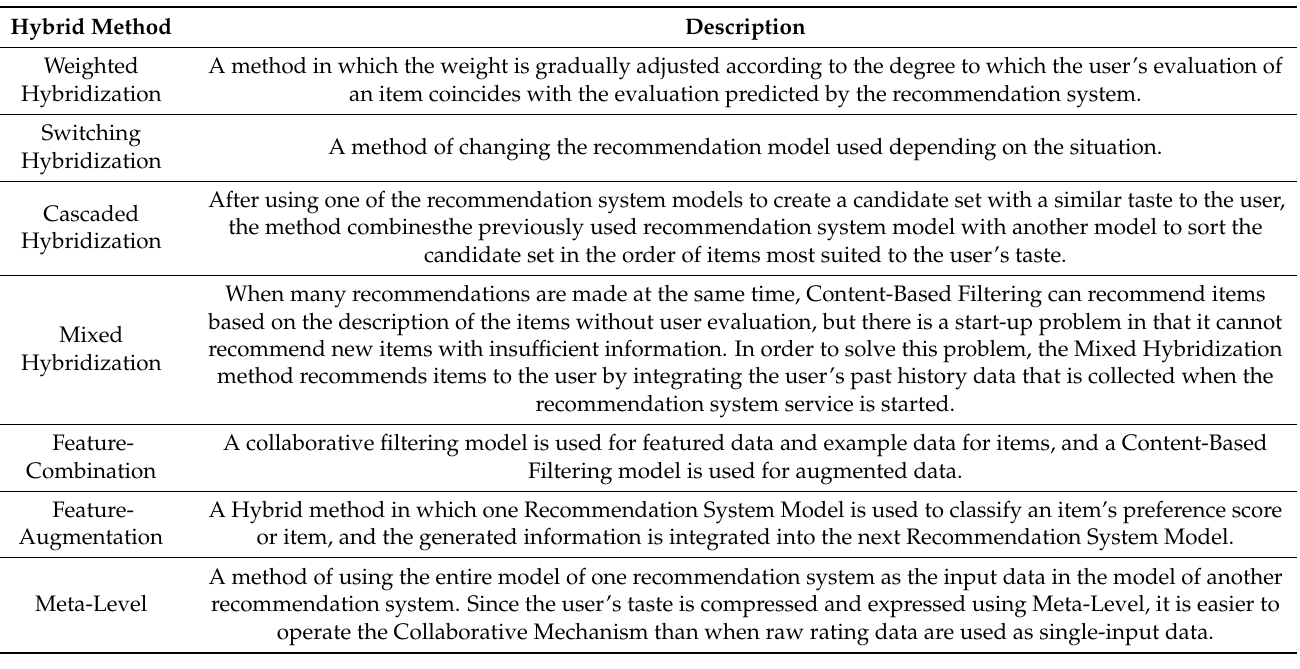
Table 1. Seven types and concepts according to the method combining the filtering technique of the Hybrid system.